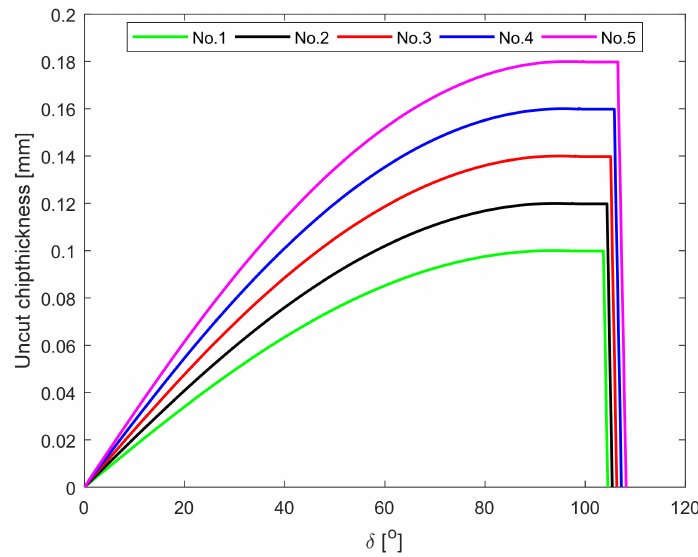
Figure 11. Uncut chip thickness on each